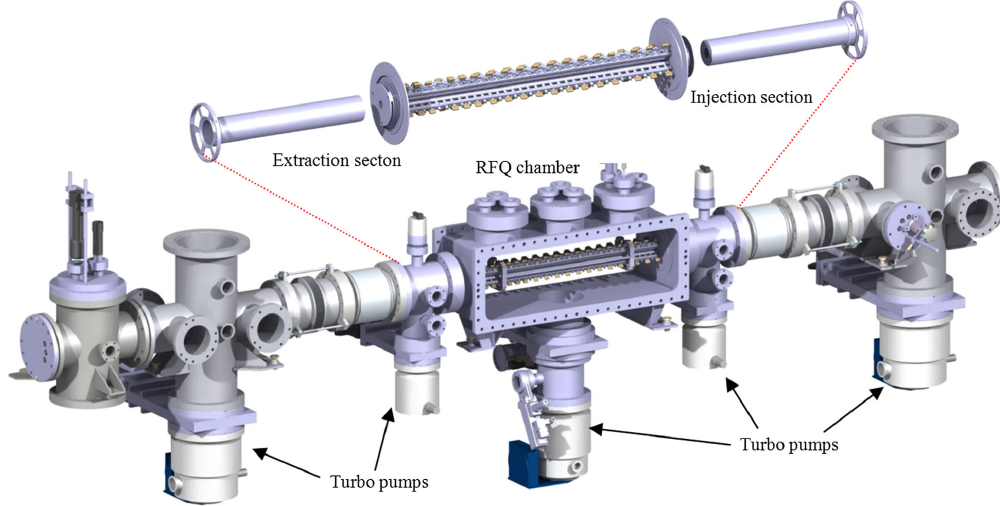
FIG. 1. Schematic of SHIRaC design: 3D layout of SHIRaC beam line with an expanded view of its optics